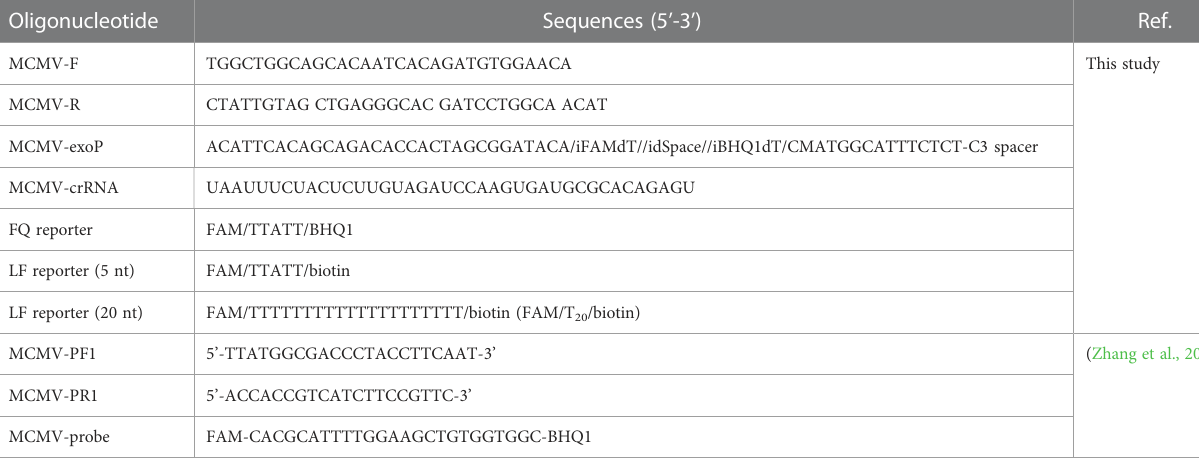
TABLE 1 Oligonucleotide sequences used in this study.